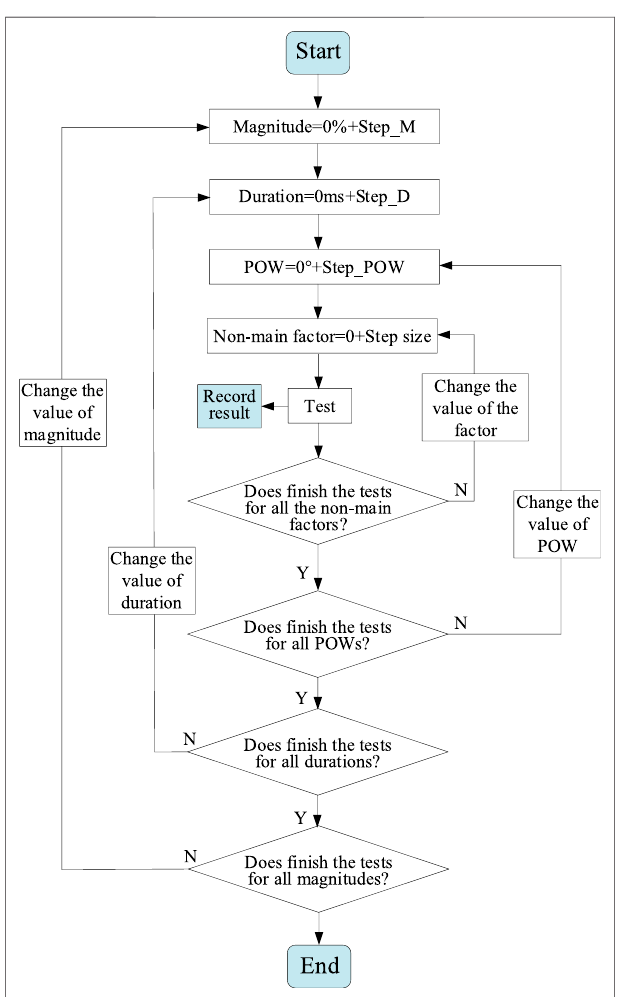
FIGURE 5 | The steps of the test.